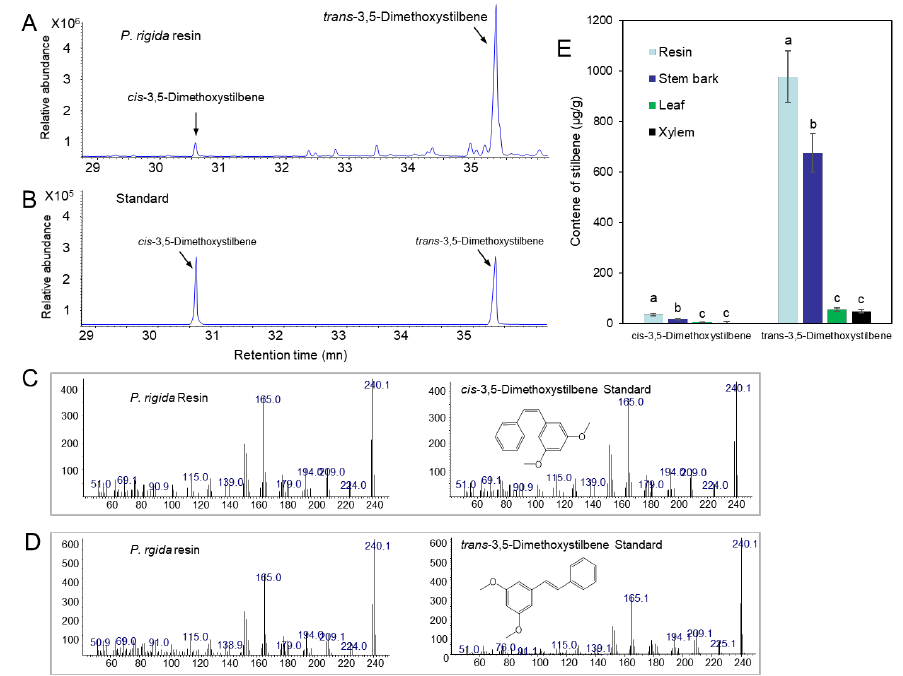
Figure 5. Identification of trans -3,5-dimethoxystilbene and cis -3,5-dimethoxystilbene and analysis of trans -3,5-dimethoxystilbene and cis -3,5-dimethoxystilbene content in different tissues of P. rigida plants. ( A ) GC chromatogram of trans -3,5-dimethoxystilbene and cis -3,5-dimethoxystilbene in resin from P. rigida. ( B ) GC chromatogram of standard trans -3,5-dimethoxystilbene and cis -3,5-dimethoxystilbene. ( C ) Mass spectra of a peak (30.58 min) detected in resin and cis -3,5-dimethoxystilbene standard. ( D ) Mass spectra of a peak (35.36 min) detected in resin and trans -3,5-dimethoxystilbene standard. ( E ) Content of trans -3,5-dimethoxystilbene and cis -3,5-dimethoxystilbene in leaf, resin, bark, and xylem. Error bars indicate the standard error of the mean (±SE) of three replicate measurements. Different letters above the bars indicate significantly different values ( p < 0.05), calculated using one-way ANOVA followed by Duncan’s post hoc analysis.